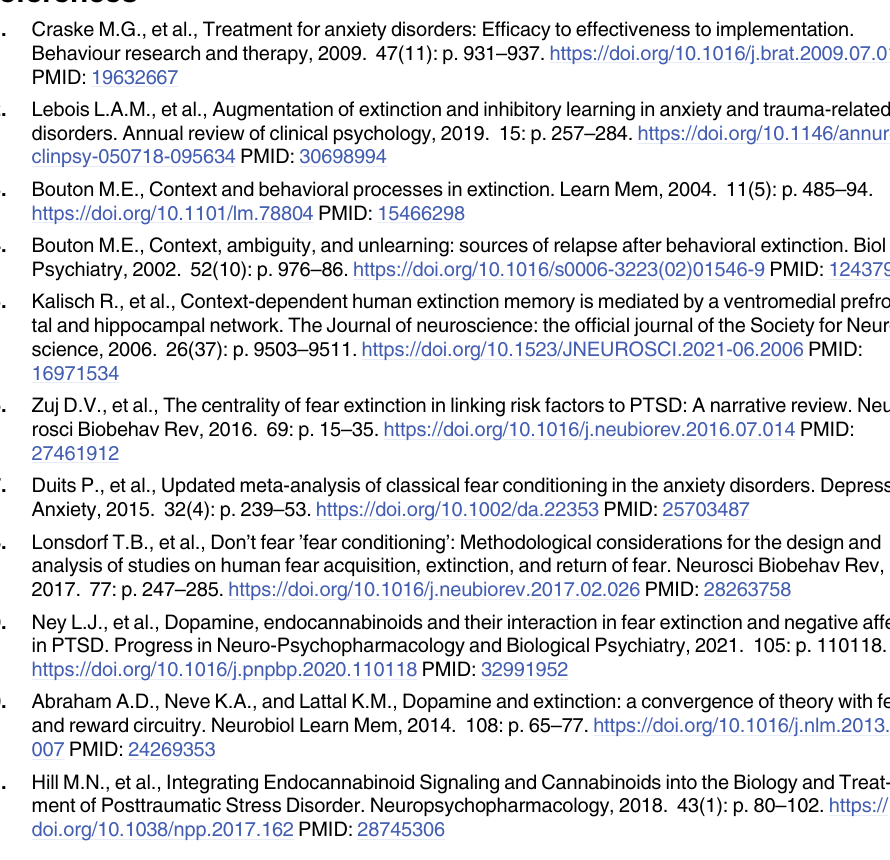
S42 Table. Early—Late Extinction, N = 960. Strategy comparisons using Kendall rank corre- lation coefficient between datasets with changes during extinction learning estimated. (DOCX) S1 Fig. Overall responding in the real data